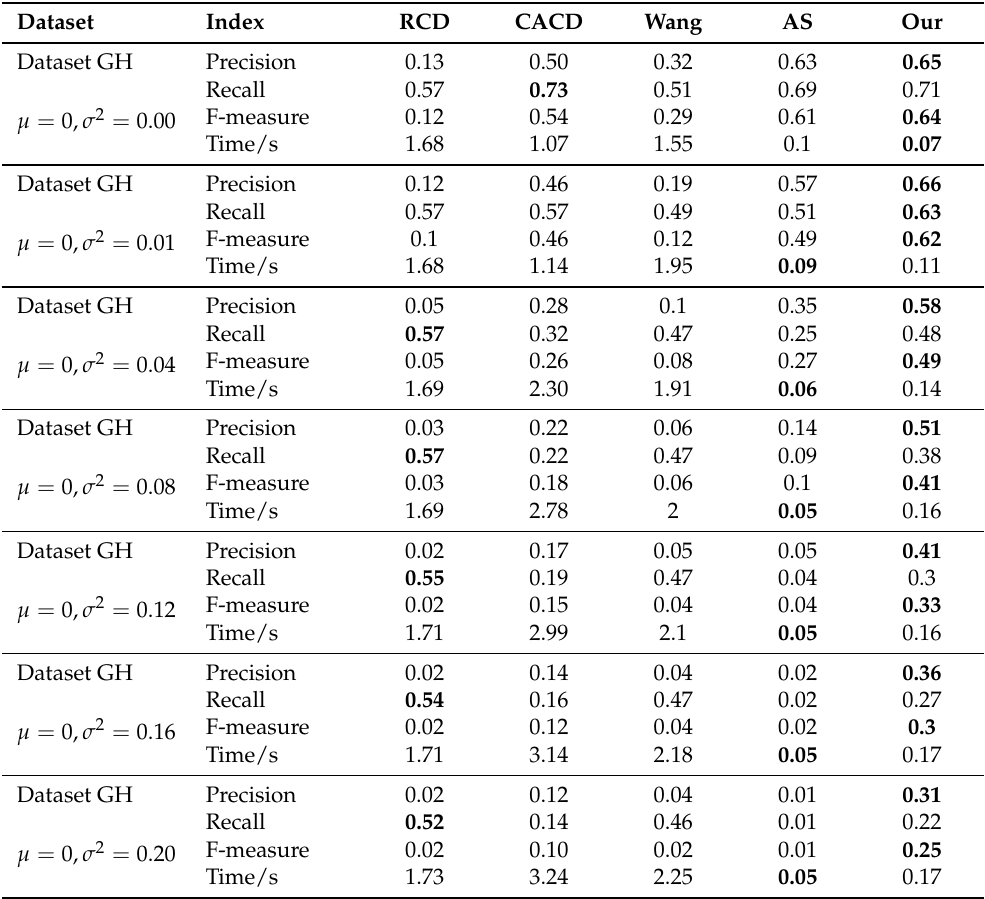
Table 1. Result on dataset